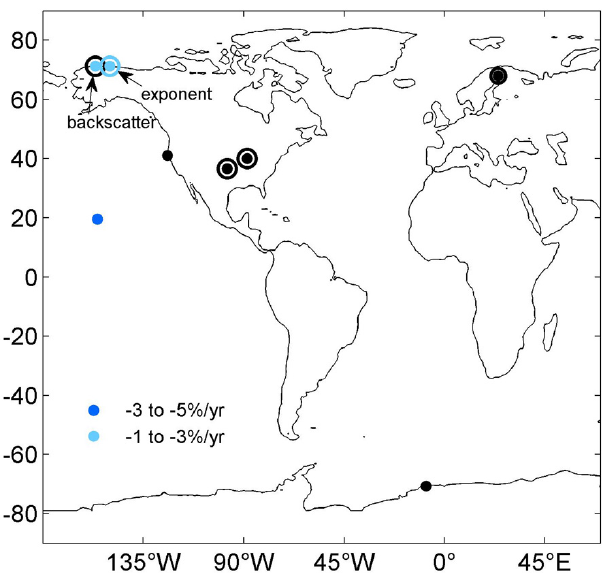
Fig. 7. Mann-Kendall trend results for the backscatter fraction and the scattering ˚Angstr¨om exponent calculated from the daily medi- ans of the scattering coefficients. All stations apart from BRW had the same trends for both parameters. The symbols have the same meaning as in Fig. 4.